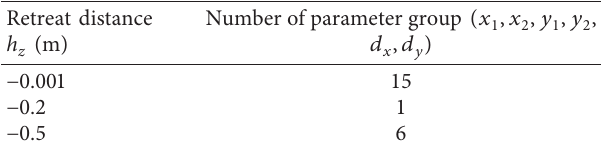
Table 2: Equivalent source configurations for confirmation. Retreat distance h z (m)